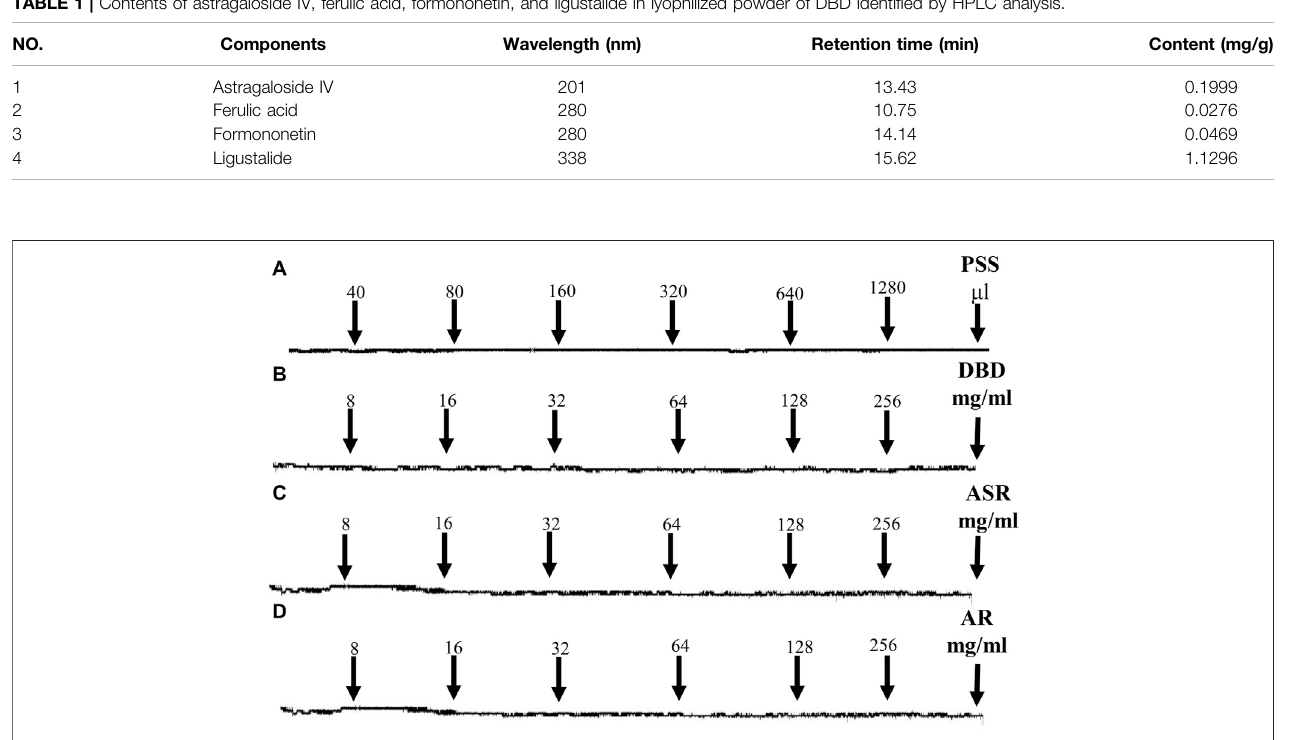
FIGURE4| EffectsofserialconcentrationsofDBD,ASR,andAR(8,16,32,64,128,and256 mg/ml)onMCAvesselsunderrestingtension.PSS(control, A ),DBD (B) , ASR (C) , and AR (D) had no effects on resting tension of MCA vessels. DBD, Danggui Buxue decoction. ASR, Angelicae Sinensis Radix. AR, Astragali Radix. MCA, middle cerebral